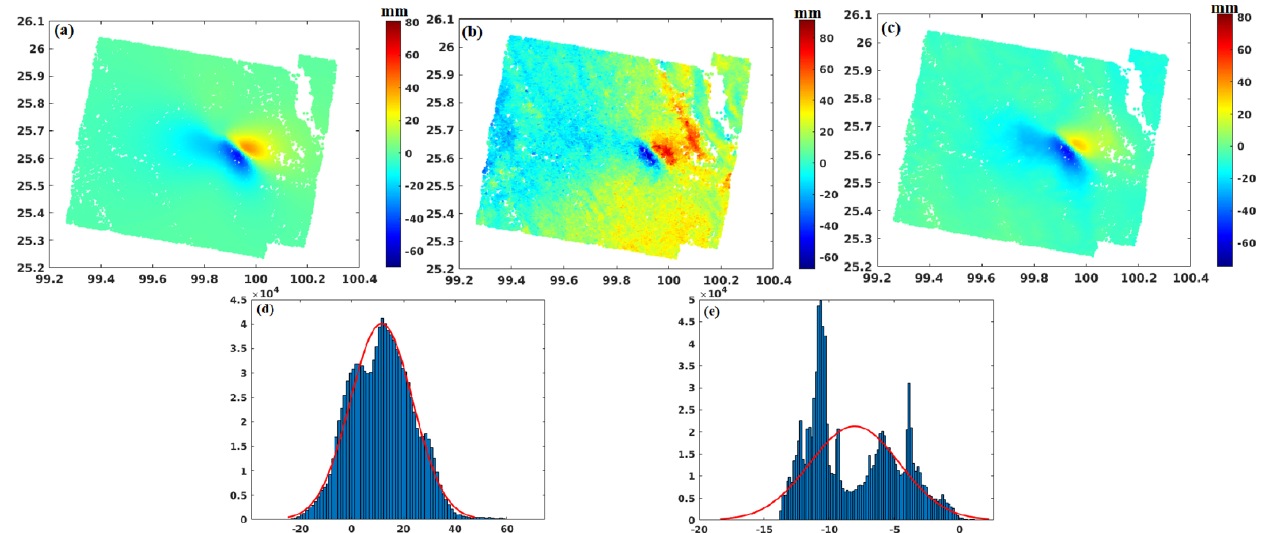
Figure 10. ( a ) represents the true coseismic deformation of the synthetic dataset; ( b ) represents the coseismic deformation extracted from the unwrapped interferogram after adding noise; ( c ) represents the coseismic deformation extracted from the synthetic dataset by the time–series InSAR processing method; ( d ) is the histogram of the difference distribution between the deformation after adding noise and the true deformation; and ( e ) is the histogram of the difference distribution between the deformation extracted by the time–series processing and the true deformation.